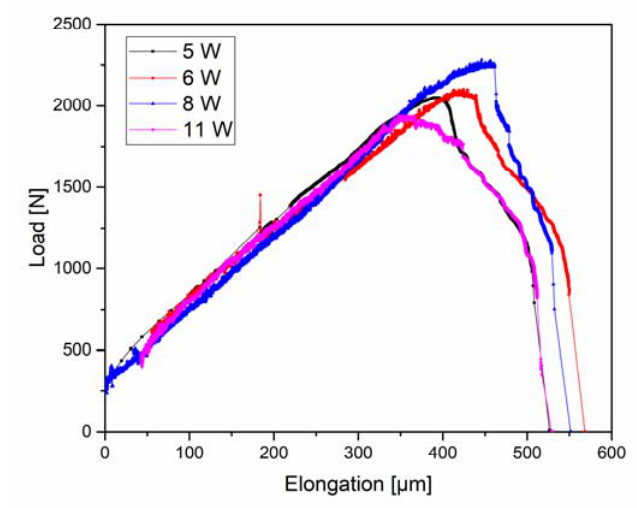
Figure 10. Load-elongation curves of CP 1200 steel tested under different plasma charging conditions. Power levels of 5 W, 6 W, 8 W, and 11 W were applied for running the plasma.